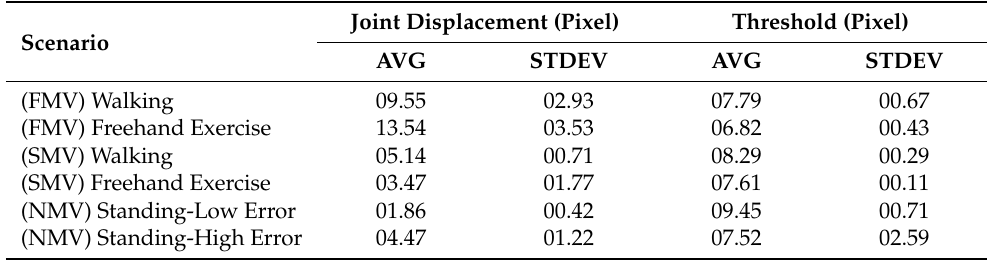
Table 4. Experiment 2 result. Each cell represents (average, standard deviation) of joint displacement and used threshold through prepared 15 video sequences. Each frame has 12 joint points of shoulder, arm, wrist, hip, leg, and ankle. Distance between left shoulder point and right shoulder point is set as a threshold. Each 12 joint displacement is calculated by comparing adjacent two frames. Average joint displacement is the average value of 12 joint displacements and its standard deviation. Units of measure are in